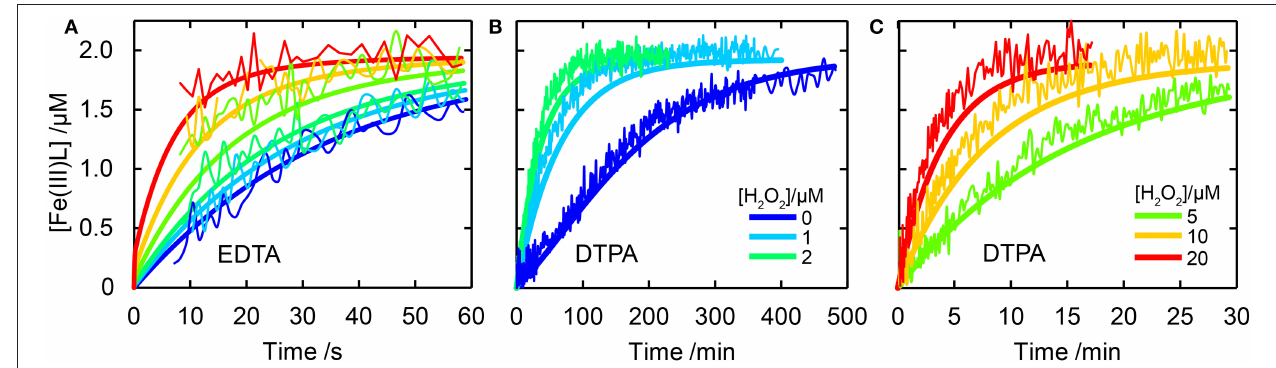
FIGURE 1 | Comparison of experimental data to model results for Fe(II)EDTA and Fe(III)EDTA oxidation studies. In all cases thin lines are experimental data and thick lines model output. Experimental conditions were [Fe(II)] 0 = 2 µ M and [EDTA or DTPA] = 10 µ M. Panel (A) shows results for EDTA for [H 2 O 2 ] = 0 (blue), 1, 2, 5, 10, and 20 µ M (red). Panel (B,C) show results for DTPA with [H 2 O 2 ] as labeled.